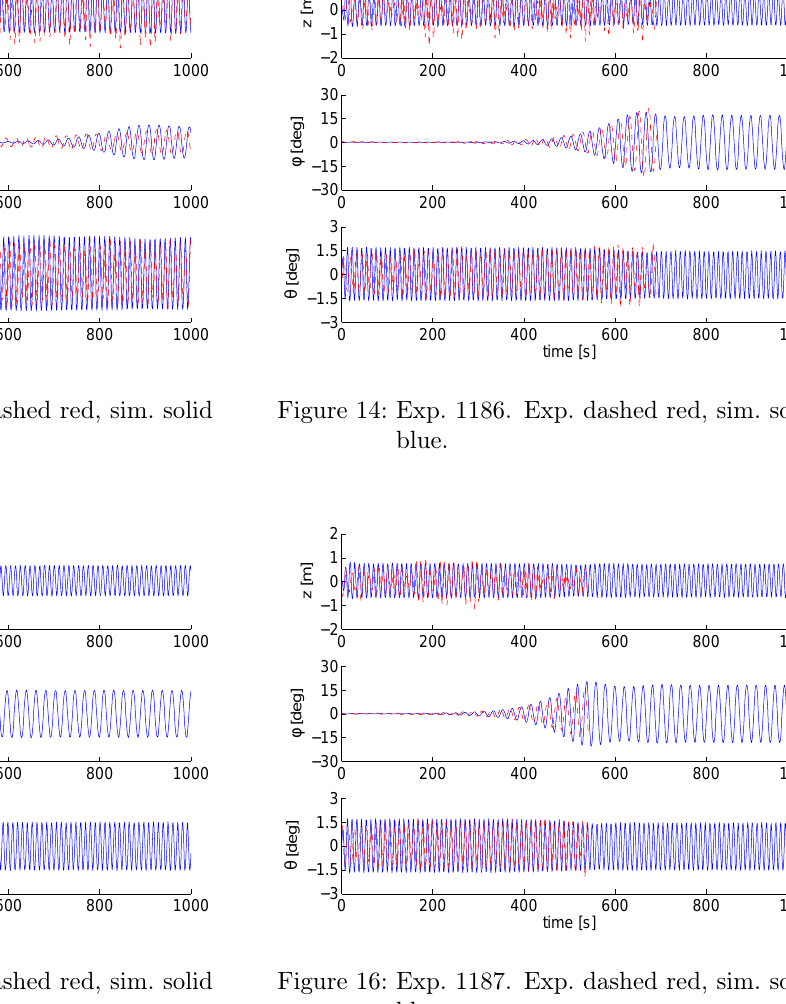
Figure 16: Exp. 1187. Exp. dashed red, sim. solid blue.